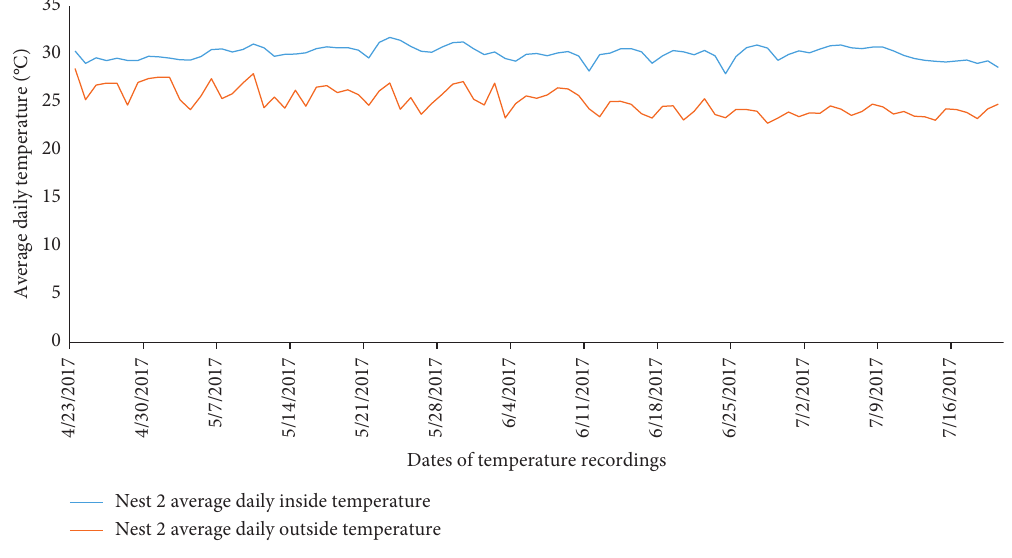
Figure 5: Variation trend of nest 2 ambient temperature and the incubation temperature.